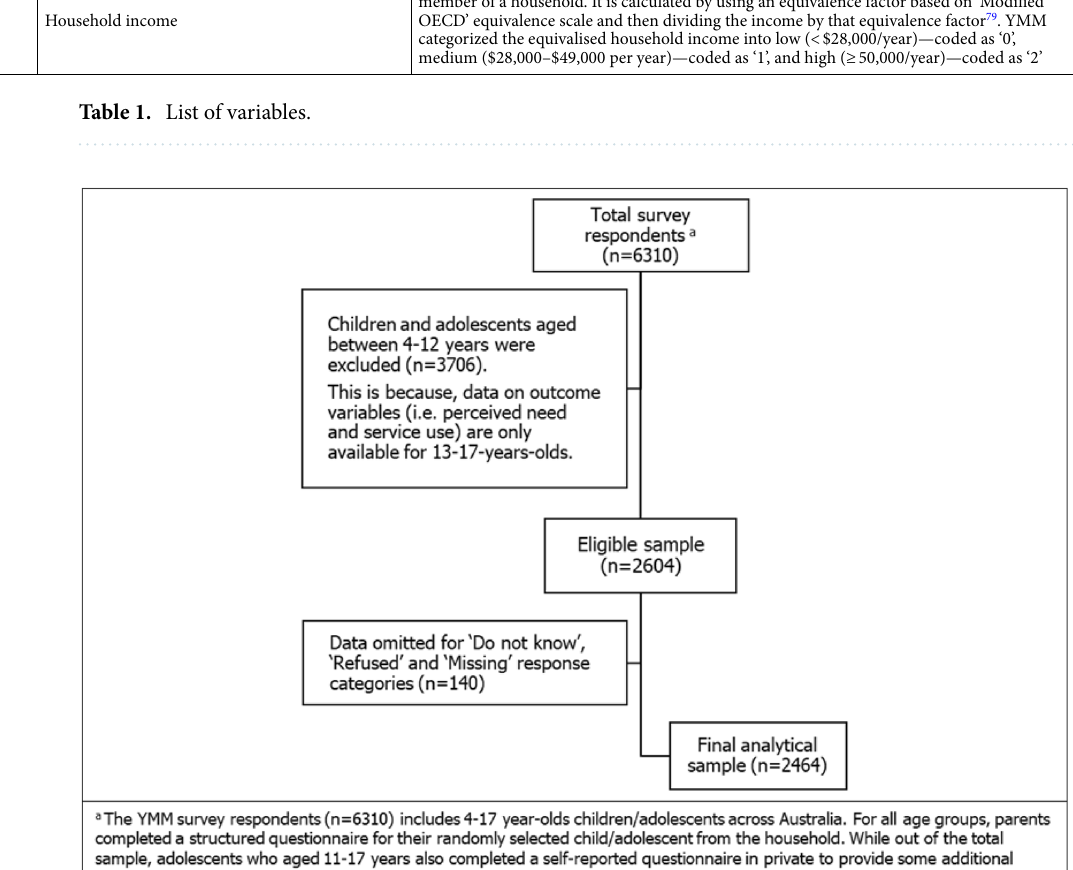
Figure 1. Flow chart for sample